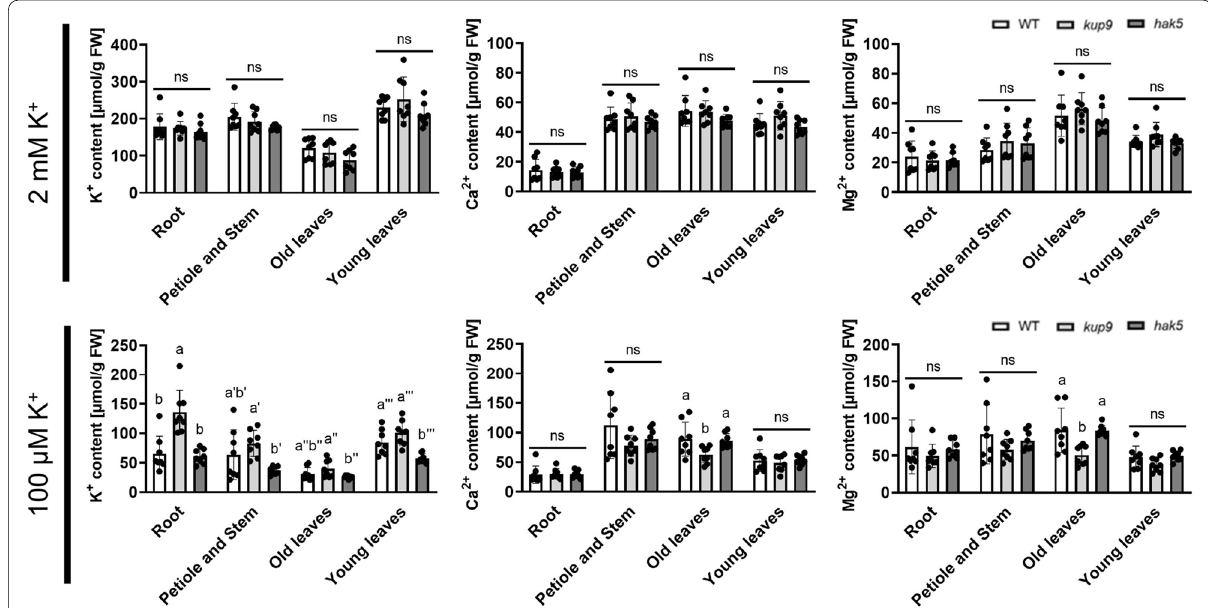
Fig. 4 K + accumulation in kup9 and hak5 . Plants were grown on synthetic agar medium containing 2 mM K + or l00 μM K + for 2 weeks. K + , Ca 2 + and Mg 2 + contents of young leaves (four youngest leaves), old leaves (remaining leaves), petioles and stems, and roots of wild-type, kup9 and hak5 plants were measured by ICP-OES. Data are shown as mean significant ( P > 0.05); one-way